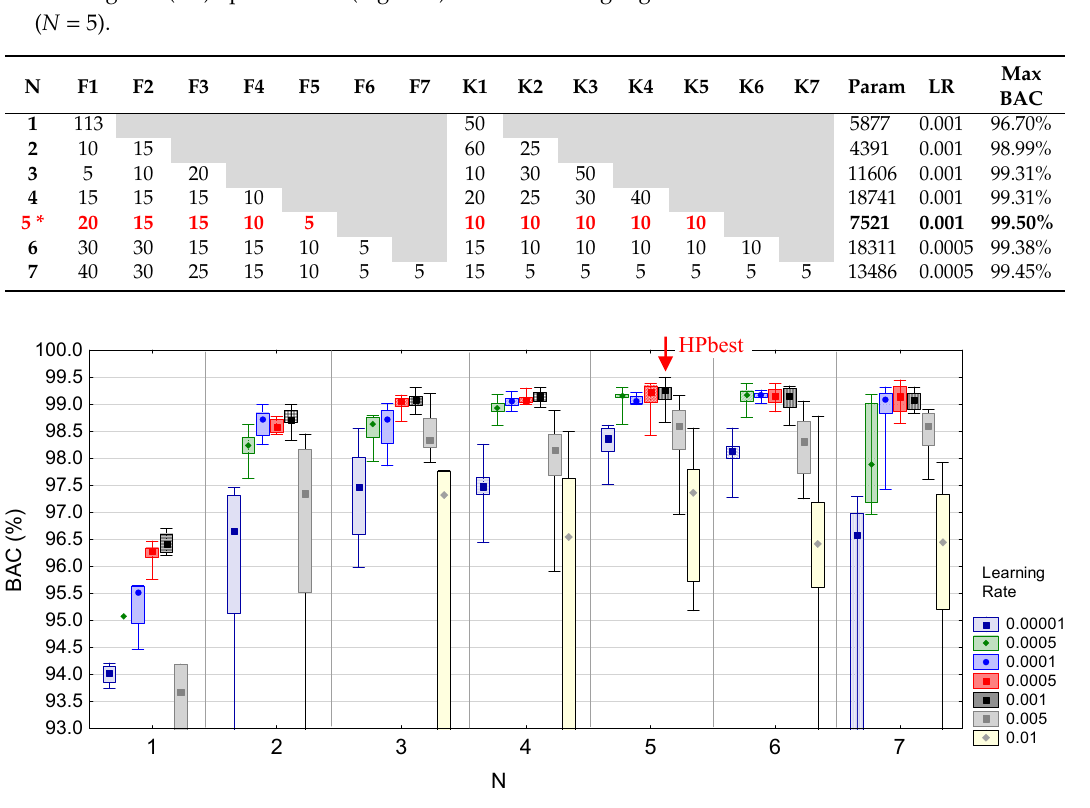
Table 3. Settings of the optimal HPs for CNNs with di ff erent numbers of convolutional layers: HPopt = { N , F i , K i } 7 The value of maxBAC is corresponding to maximal performance achieved after i = 1